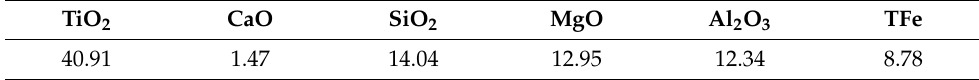
Table 2. Chemical composition of the Ti-bearing slag